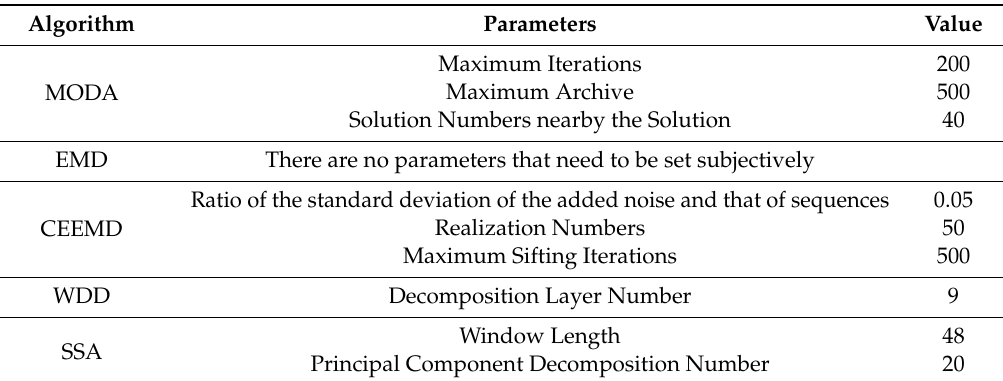
Table 4. Parameters in experiment